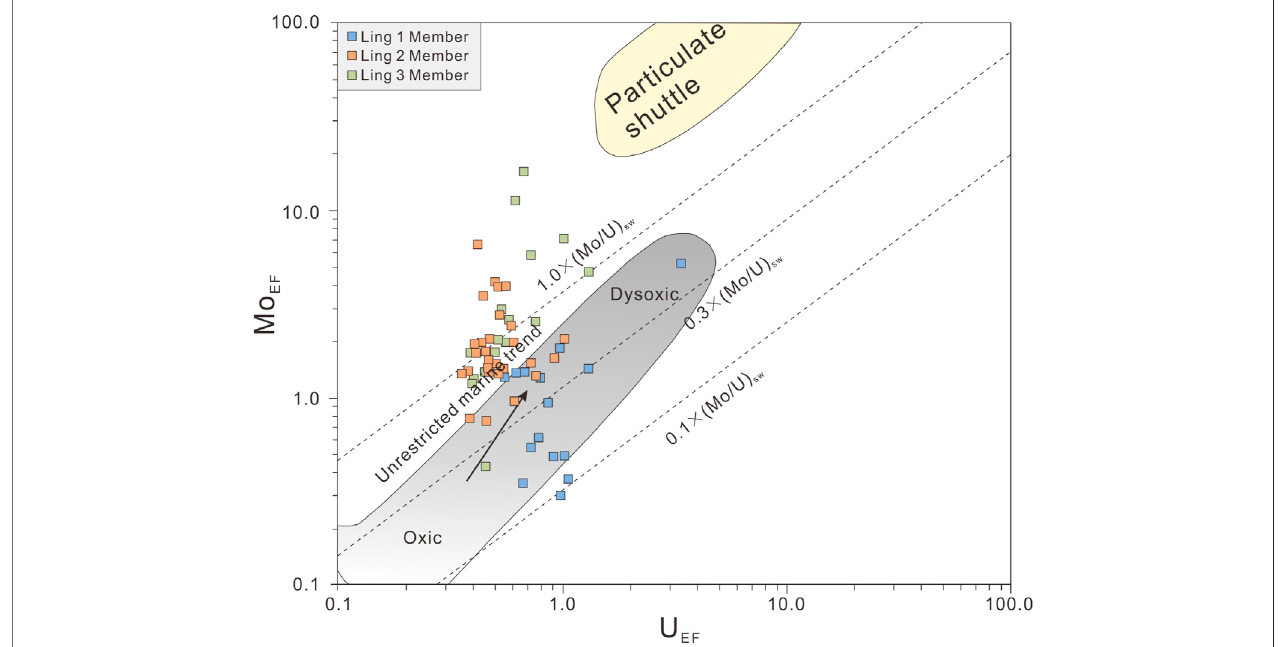
FIGURE11| AuthigenicMo-UcovariationpatternsforLinghaoFormationmarineshale.ThediagonaldashedlinesrepresenttheMo/Umolarratiosoftheseawater (sw). Grey area represents the “ unrestricted marine ” trend, characteristic of depositional systems with no limited trace metal renewal. The yellow area represents the “ particulate shuttle ” trend, characteristic of environments in which intense redox cycling of metals occurs within the water column (Algeo and Tribovillard, 2009; Tribovillard et al.,